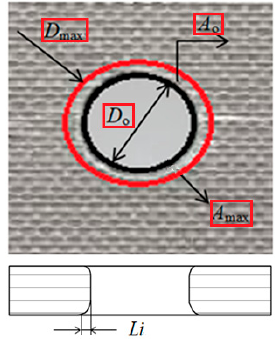
Figure 12. The defect diagram of tearing.